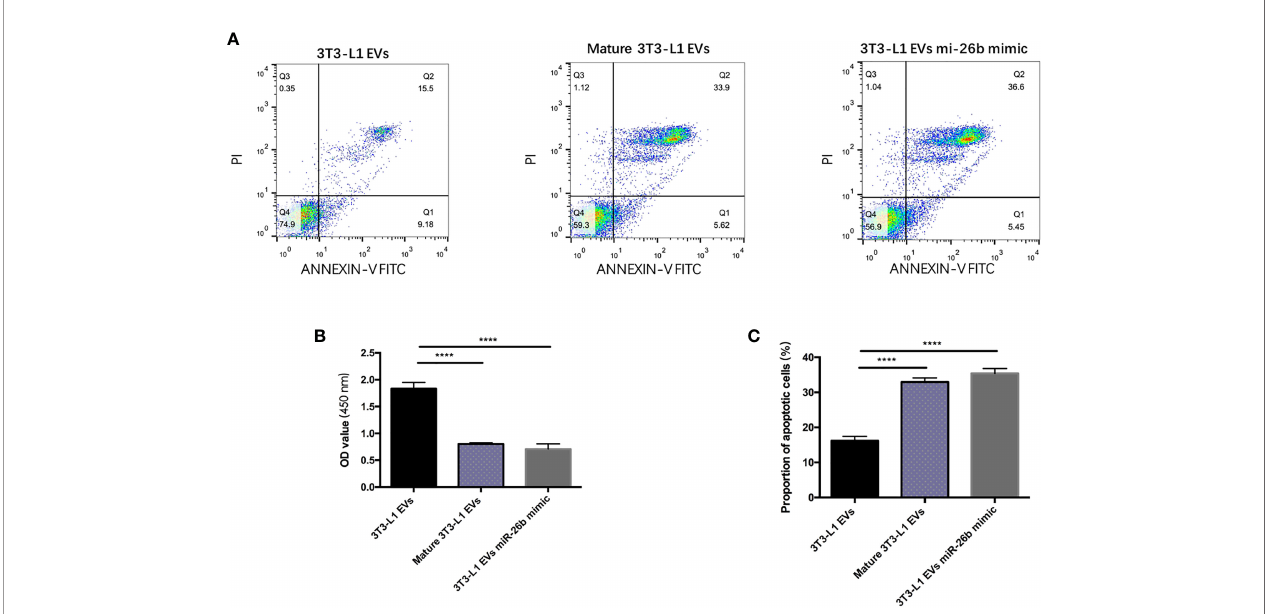
FIGURE 3 | Adipocytes-derived extracellular vesicles inhibited CCs proliferation. (A) Detecting the apoptosis of CC cells treated with 3T3-L1 EVs (left), mature 3T3- L1 EVs (middle), and 3T3-L1 EVs mi-26b mimic (right) via fl ow cytometry. (B) Detecting the viability of CC cells treated with 3T3-L1 EVs, mature 3T3-L1 EVs, and 3T3-L1 EVs mi-26b mimic via CCK8 assay. (C) Quanti fi cation of the apoptosis detected via fl ow cytometry; ****p < 0.0001.